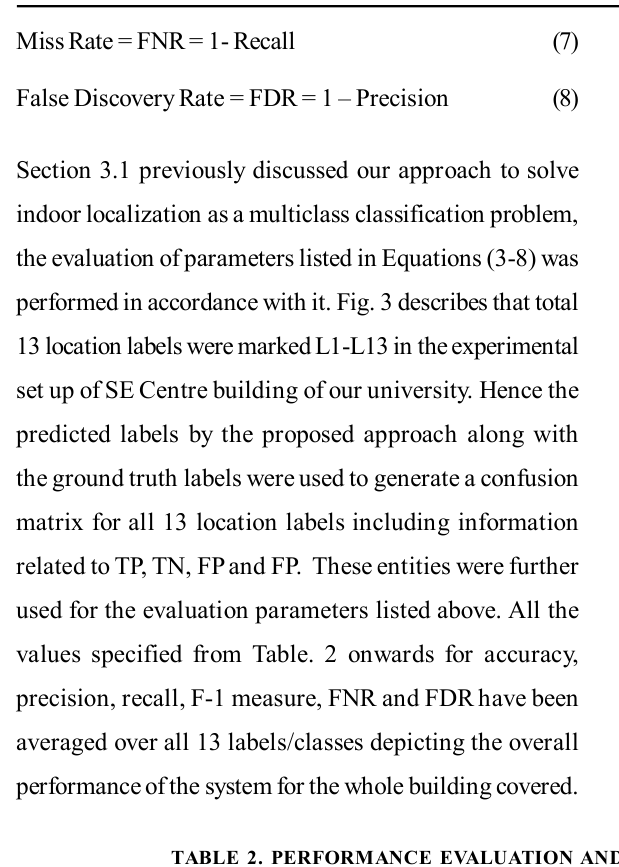
TABLE 2. PERFORMANCE EVALUATION AND COMPARISON OF PROPOSED